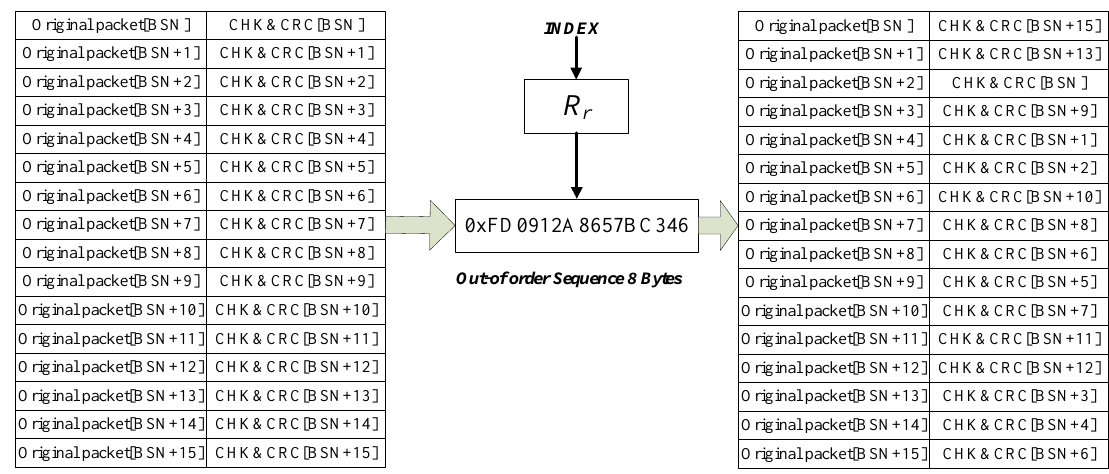
Figure 4. Random Delayed Transmitting Scheme.